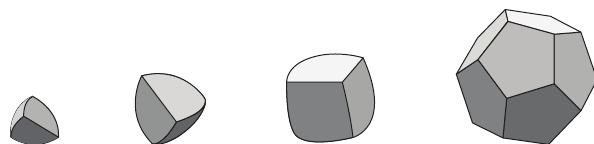
Figure 1. Geometry of the average 4-hedron. Depiction of the interfacial angle, α ≈ 109.5°, is shown between adjacent face-centered normals, N N . Owing to the curved face the face normals rotate and meet at the edge 2 with an angle equal to 60° prescribed by equilibrium condition at the triple lines. Notice that the angle between face normals, 60°, is half the dihedral angle, 120°.